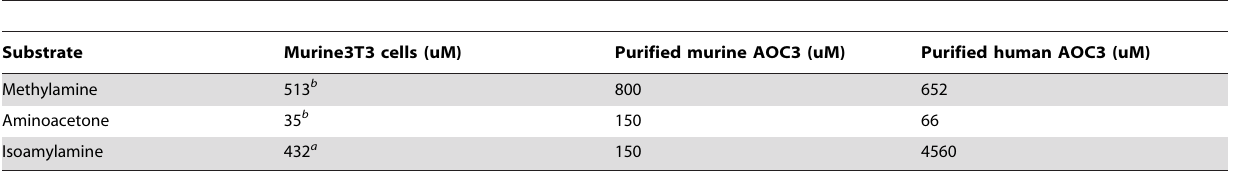
Table 4. Comparison of AOC3 K m values determined by steady state kinetic studies of purified murine enzyme and whole cell 3T3- L1